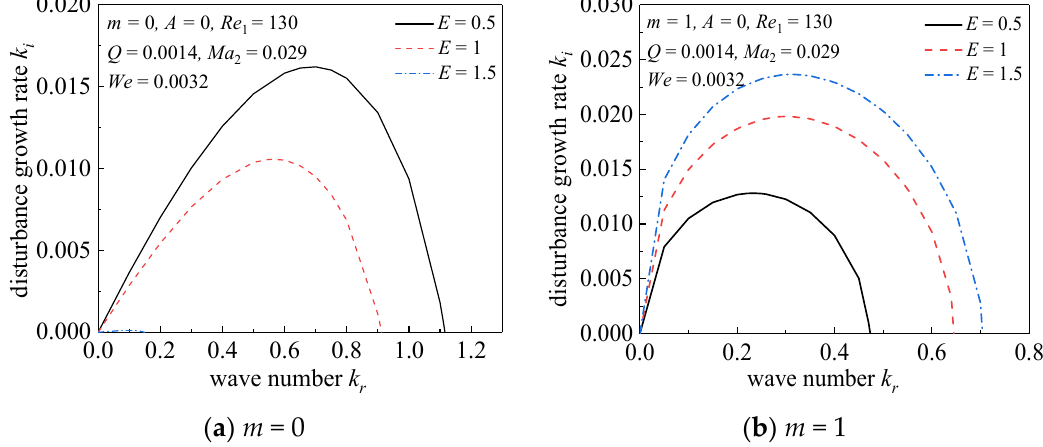
Figure 5. Effects of the swirling airflow on jet stability under the axisymmetric and asymmetry mode.